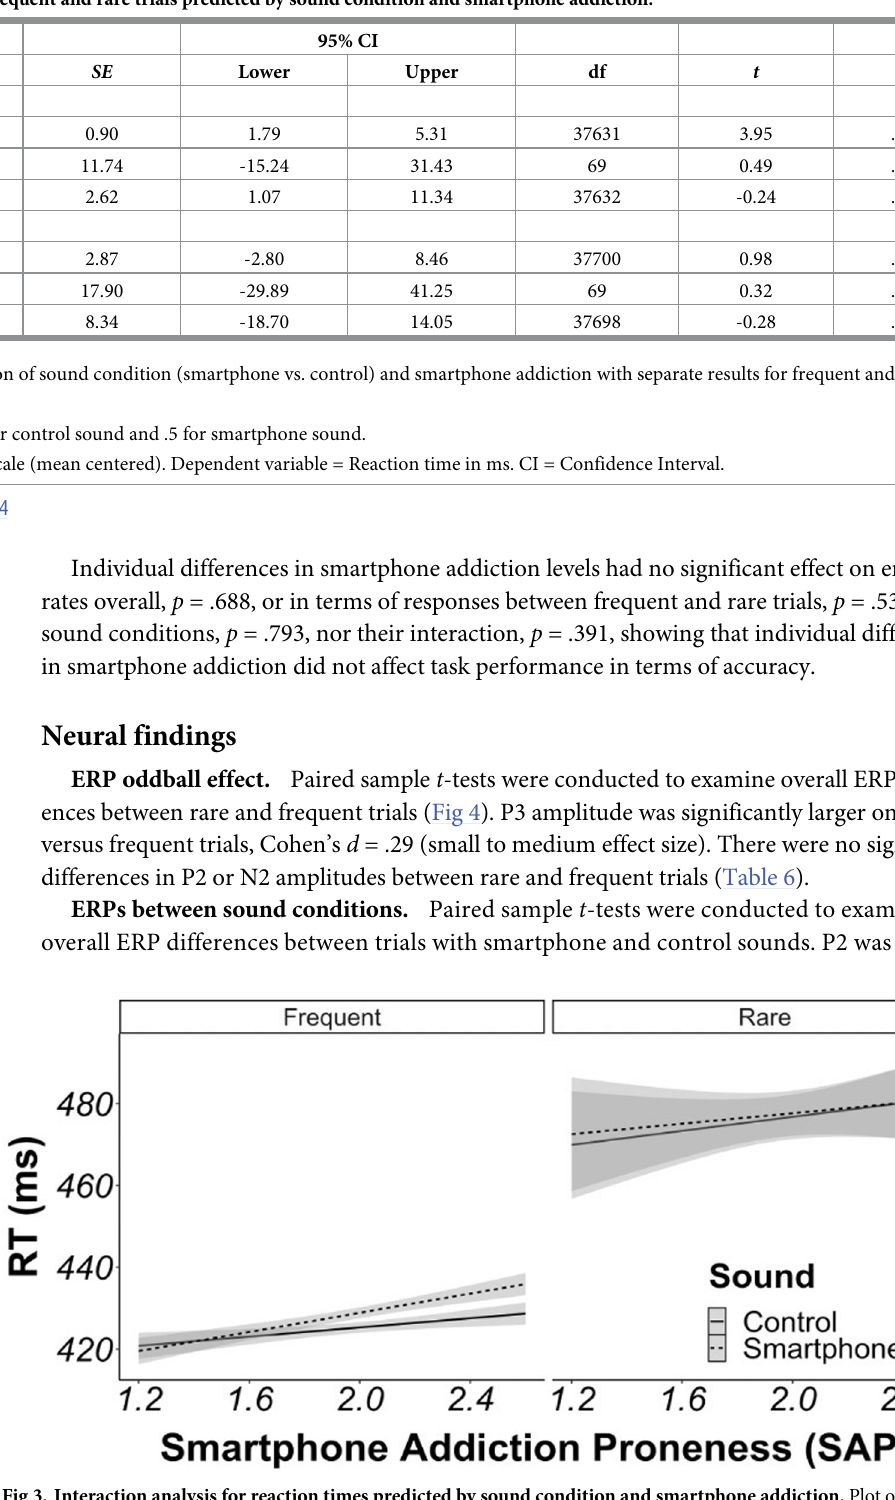
Table 4. Regressions for reaction times on frequent and rare trials predicted by sound condition and smartphone addiction.